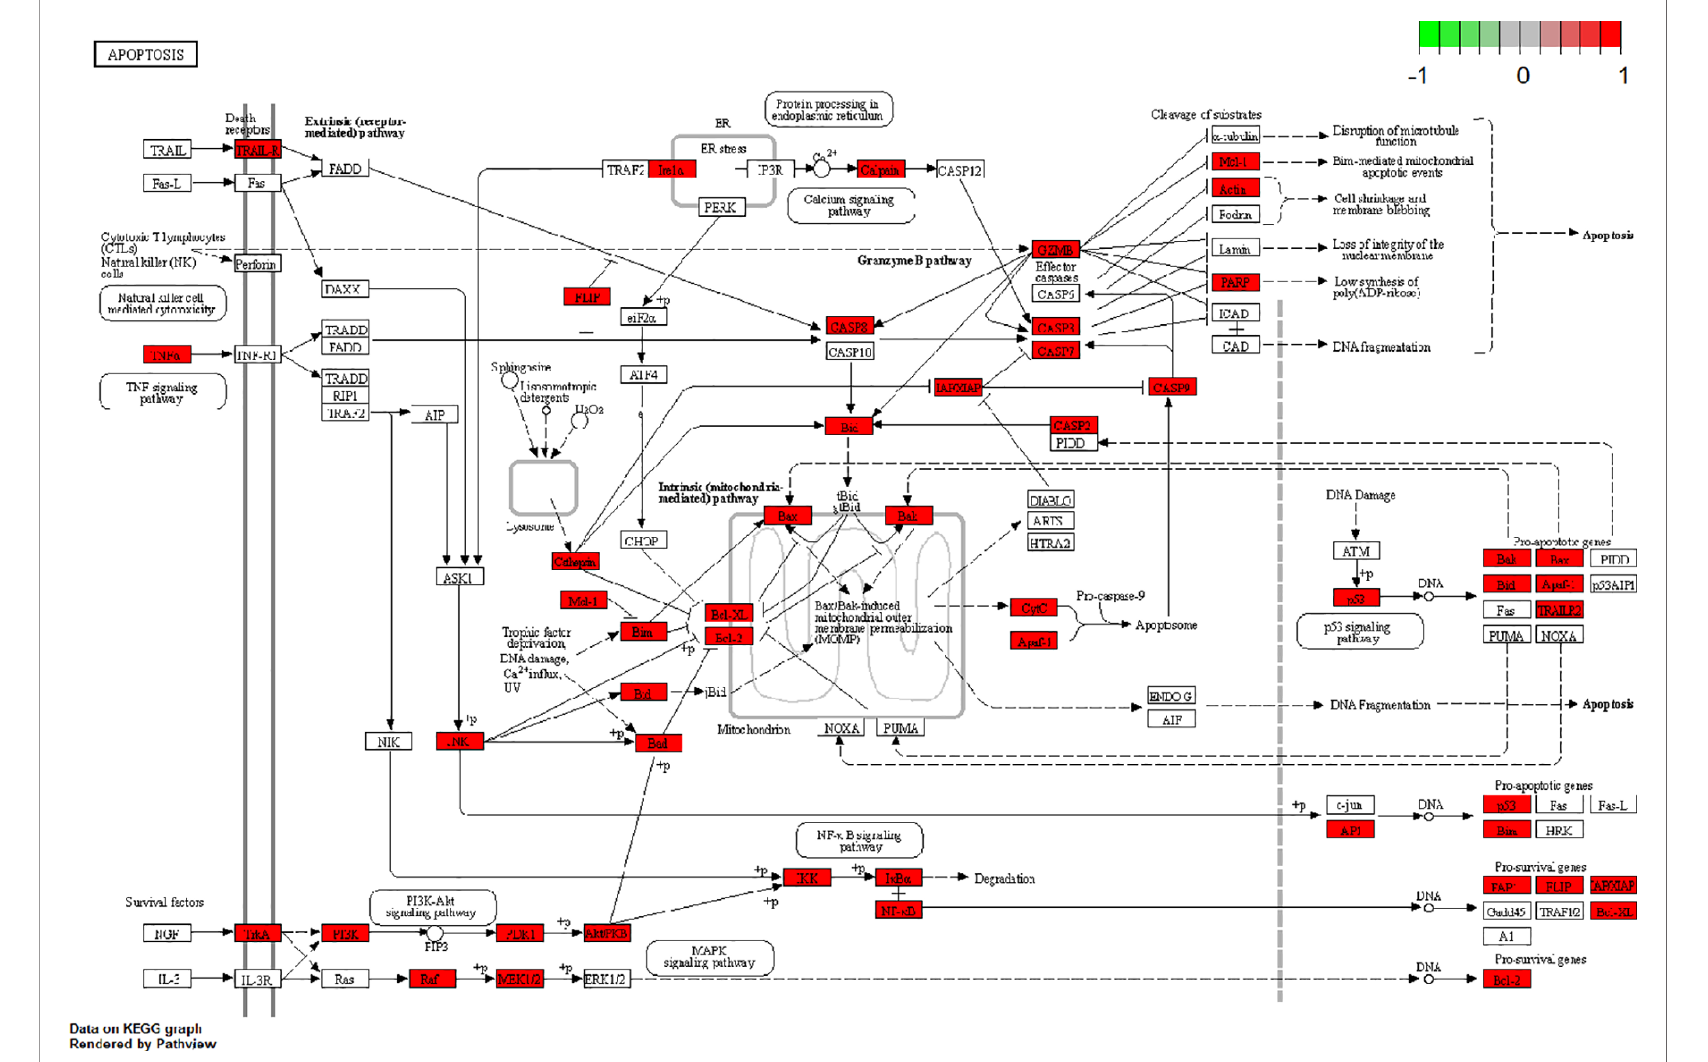
FIGURE 6 | The potential apoptotic pathway for anticancer effects of RPL against lung